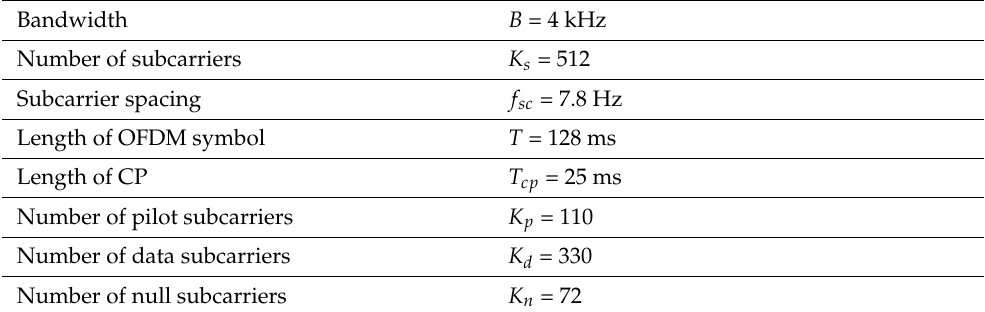
Table 4. Parameters used in the cluster-based adaptive modulation during the river experiment.